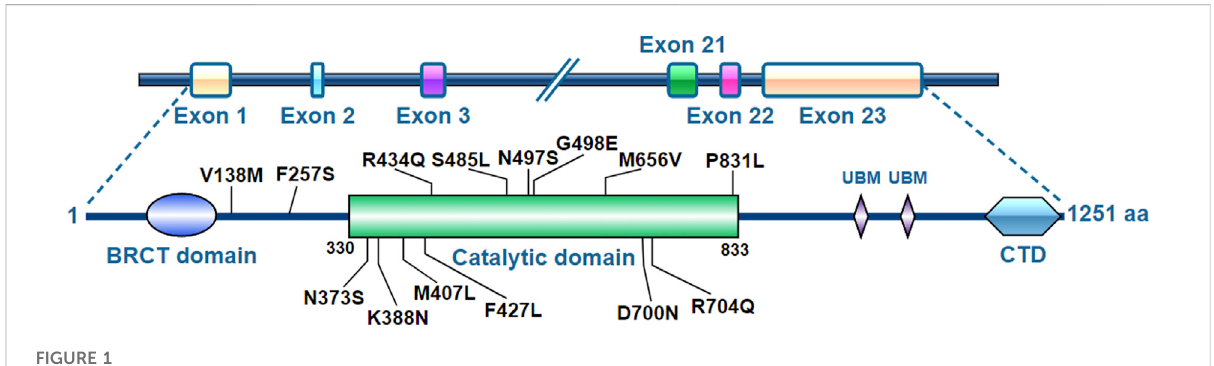
FIGURE 1 Molecular structure of